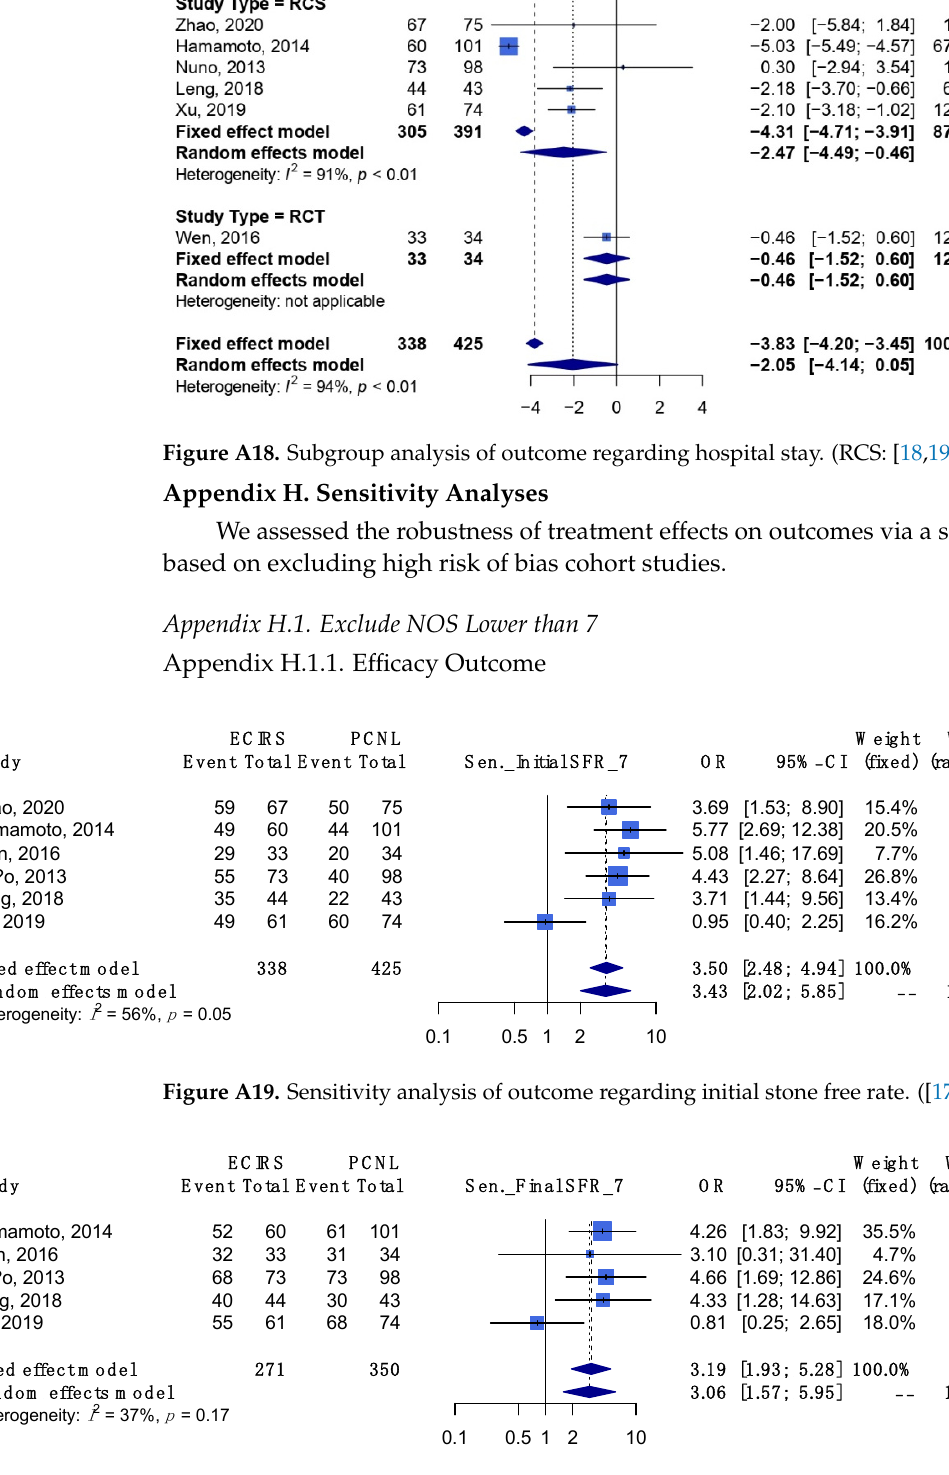
Figure A20. Sensitivity analysis of outcome regarding final stone free rate. ([17,19,20,22,23])